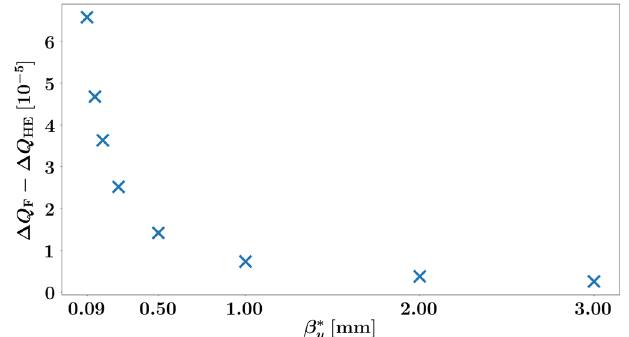
FIG. 6. Deviation of the calculated β (cid:1) y as a function of β (cid:1) y in LER, found from simulations using SAD in the absence of uncertainties.